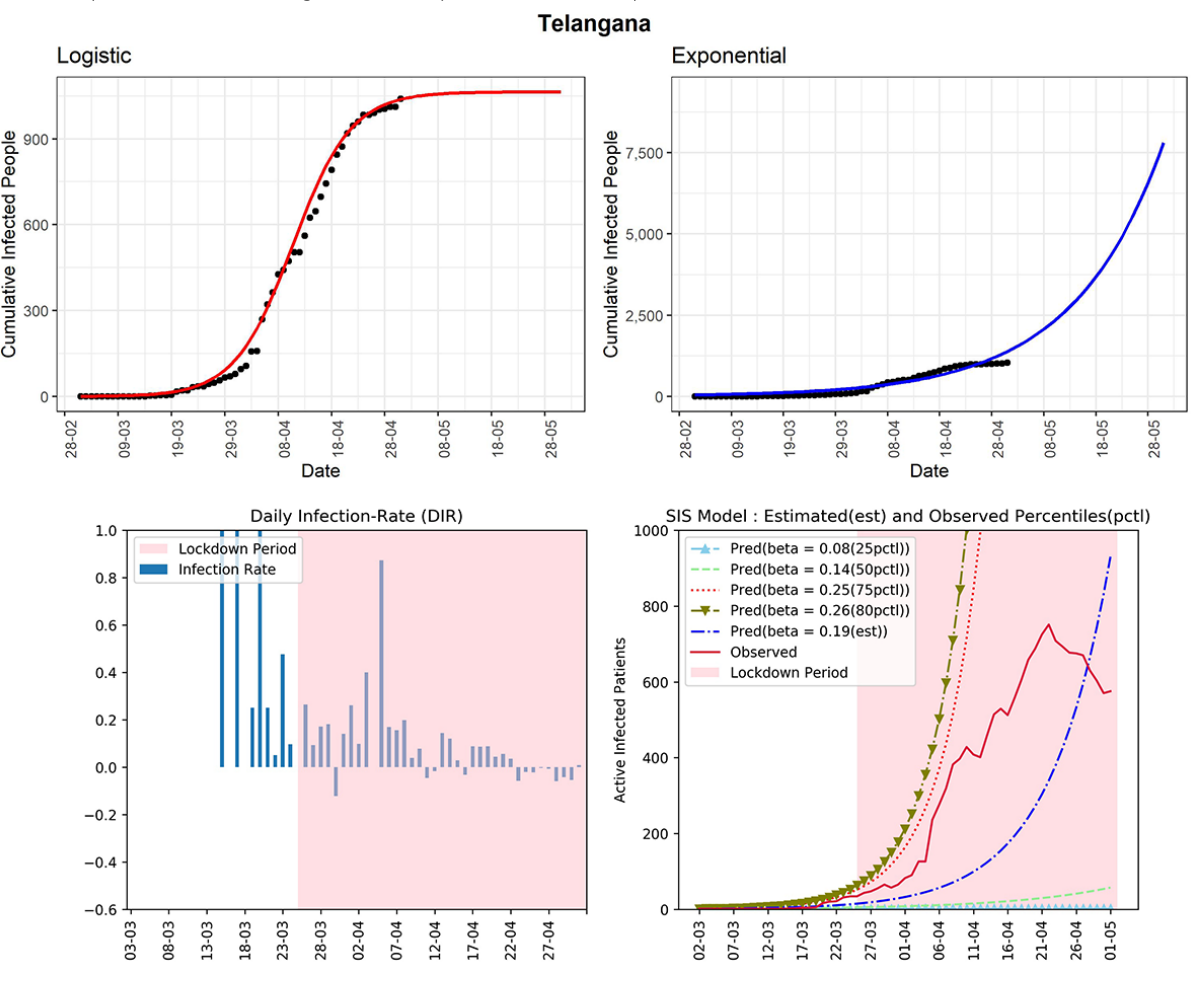
Figure 11. Graphs for the state of Telangana. SIS: